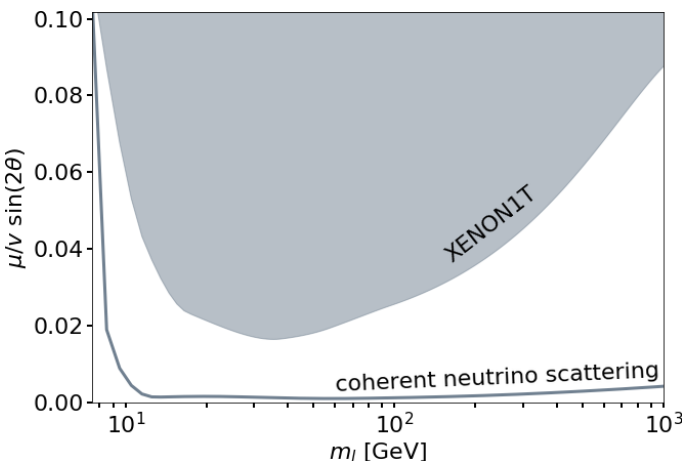
Figure 2 . Bounds from Xenon1T [32] on the Higgs coupling to dark matter, as a function of the dark matter mass. The grey region is excluded at 90 % con(cid:12)dence level. The results have been obtained using micrOMEGAs